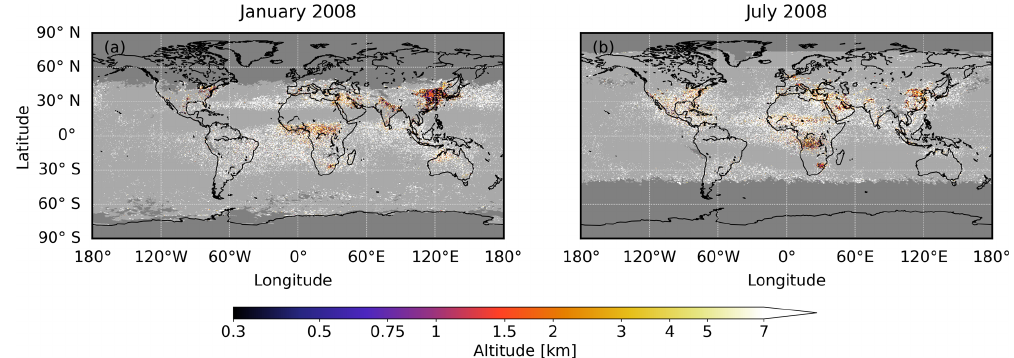
Figure 10. Monthly mean top altitudes retrieved from the ratio between the UV and blue spectral range. To retrieve the altitude, box profiles are assumed for the tropospheric NO 2 . Light-grey-coloured values indicate values where the vis blue NO 2 is close to zero, which have been filtered